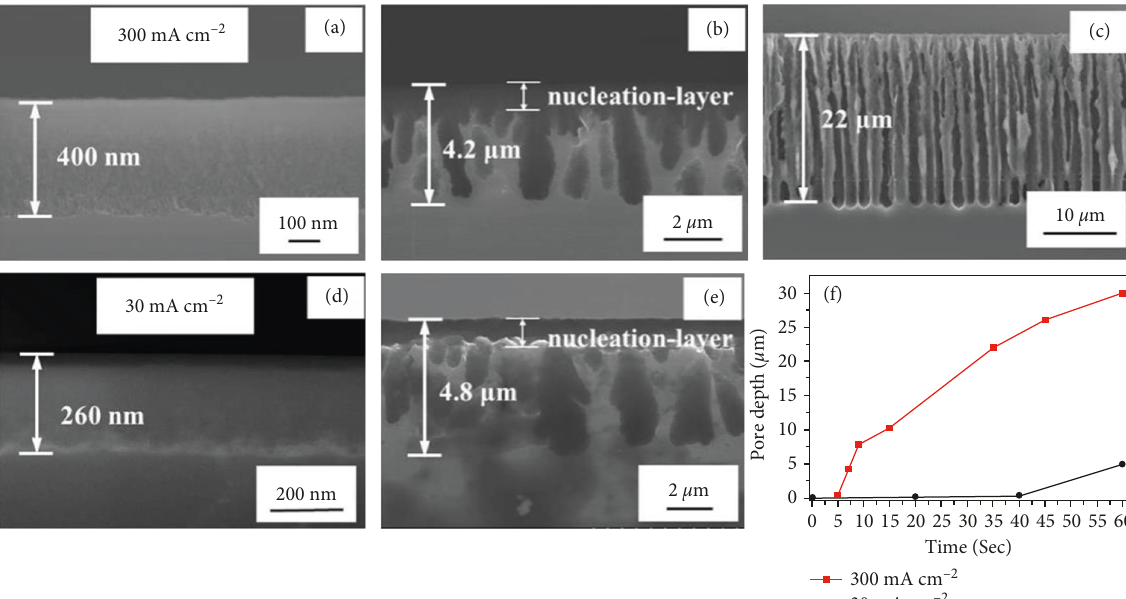
Figure 8: Nucleation process of p-type pore formation with different current densities: (a–c) SEM micrographs of pores formed at 300mA · cm − 2 over (a) 5s, (b) 7s, and (c) 35s; (d, e) SEM micrographs of pores formed at 30mA · cm − 2 over (d) 40s and (e) 60s; (f) pore depth versus time. All samples were anodized in electrolyte composed of 53 vol% HF (HF : DMF � 4 :3) [80] under the terms of the creative commons CC BY